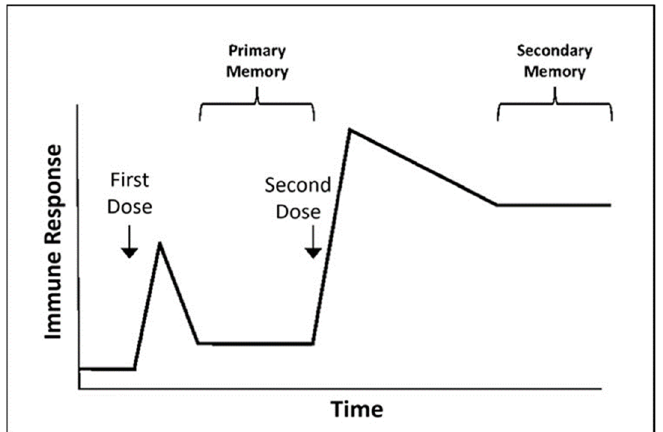
Figure 2. The prime-boost immunization strategy. The first dose of vaccine is given to activate the recipient’s immunity. In order to strengthen the recipient’s immunity, the second dose of vaccine is given approximately two weeks after the first dose. This strategy aims to stimulate previously activated memory immune cells to give heightened, long-lasting protective immunity.